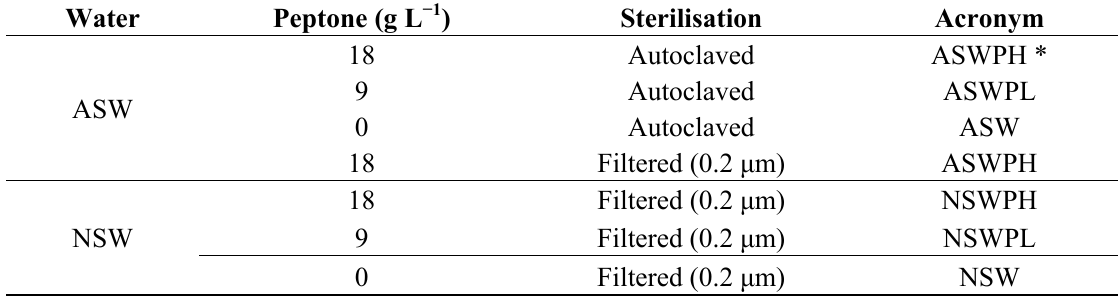
Table 4. Experimental media for C. marina and M. hydrocarbonoclasticus . ASW, artificial sea water; NSW, natural sea water; P, peptone; H, high concentration (18 g L − 1 ); and L, low concentration (9 g L − 1 ). SSP, sea salts and